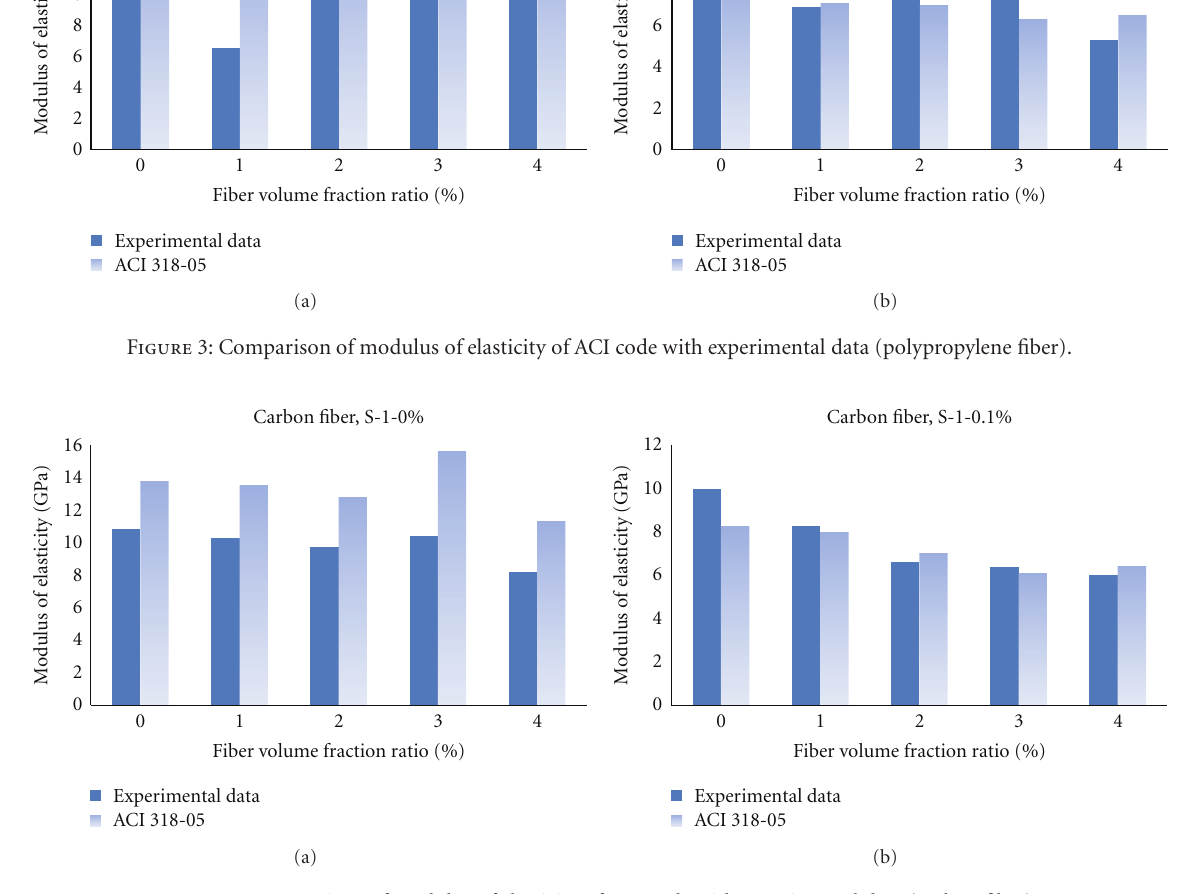
Figure 4: Comparison of modulus of elasticity of ACI code with experimental data (carbon